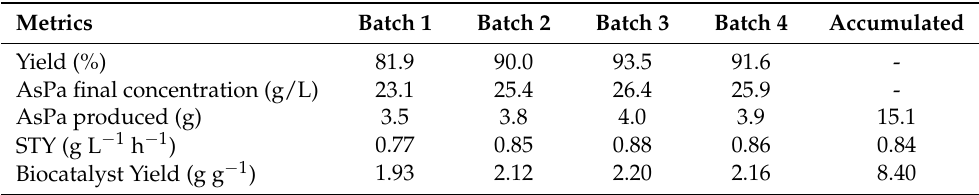
Table 3. Summary of the main metrics obtained in the synthesis of ascorbyl palmitate in a rotating bed reactor operated in sequential batches.